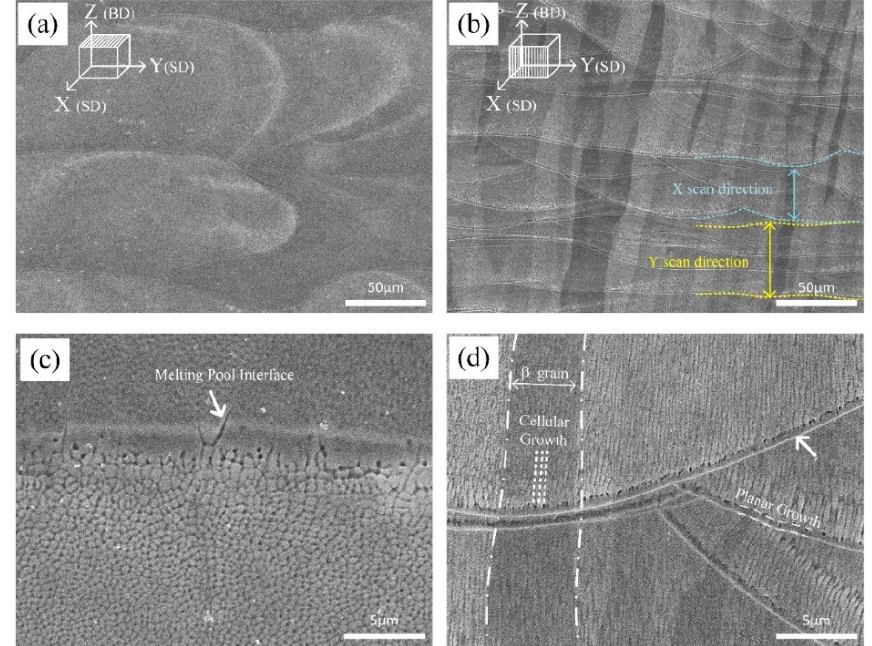
Figure 3. Low ( a , b ) and high ( c , d ) magnification SEM views from the top ( a , c ) and cross section ( b , d ) AB microstructure, columnar β grains growth were formed along the building direction (BD). Elongated cells grew in both X and Y scan directions (SD), and melting pool interface is indicated by the arrow.